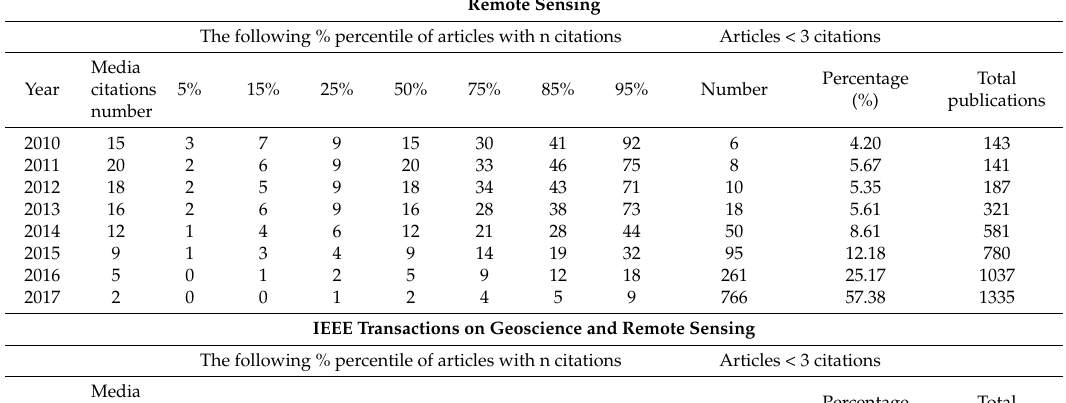
Table 16. Comparison with two of the best remote sensing journals about citations from 2010–2017. Remote Sensing The following % percentile of articles with n